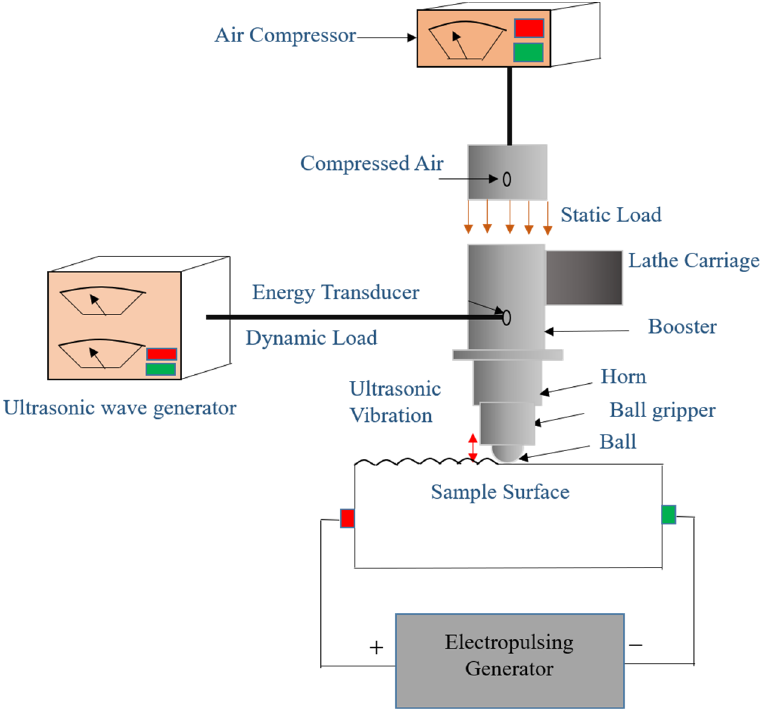
Figure 18. Schematic of EP-UNSM.